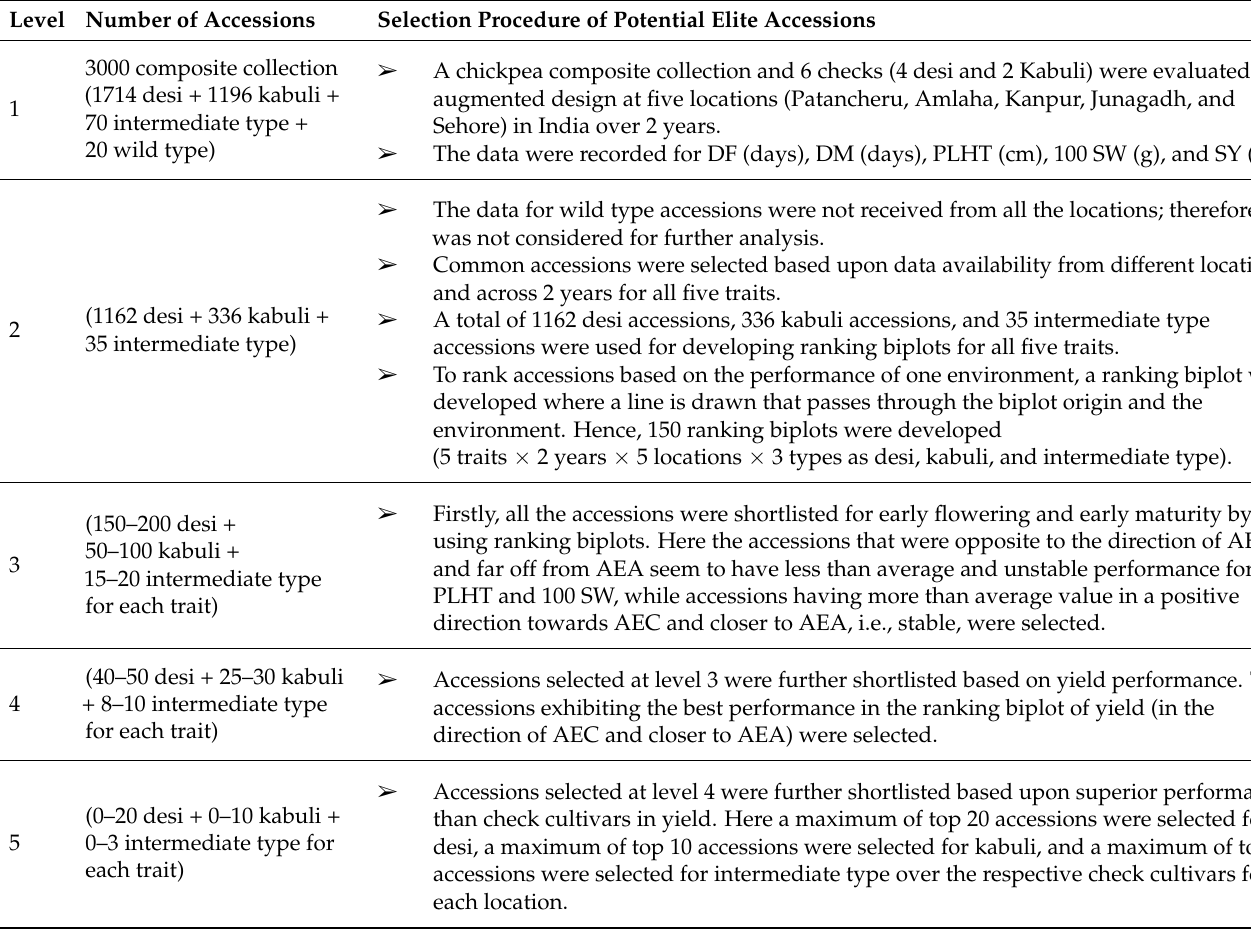
Table 2. Flow chart for selection of the germplasm accessions at each